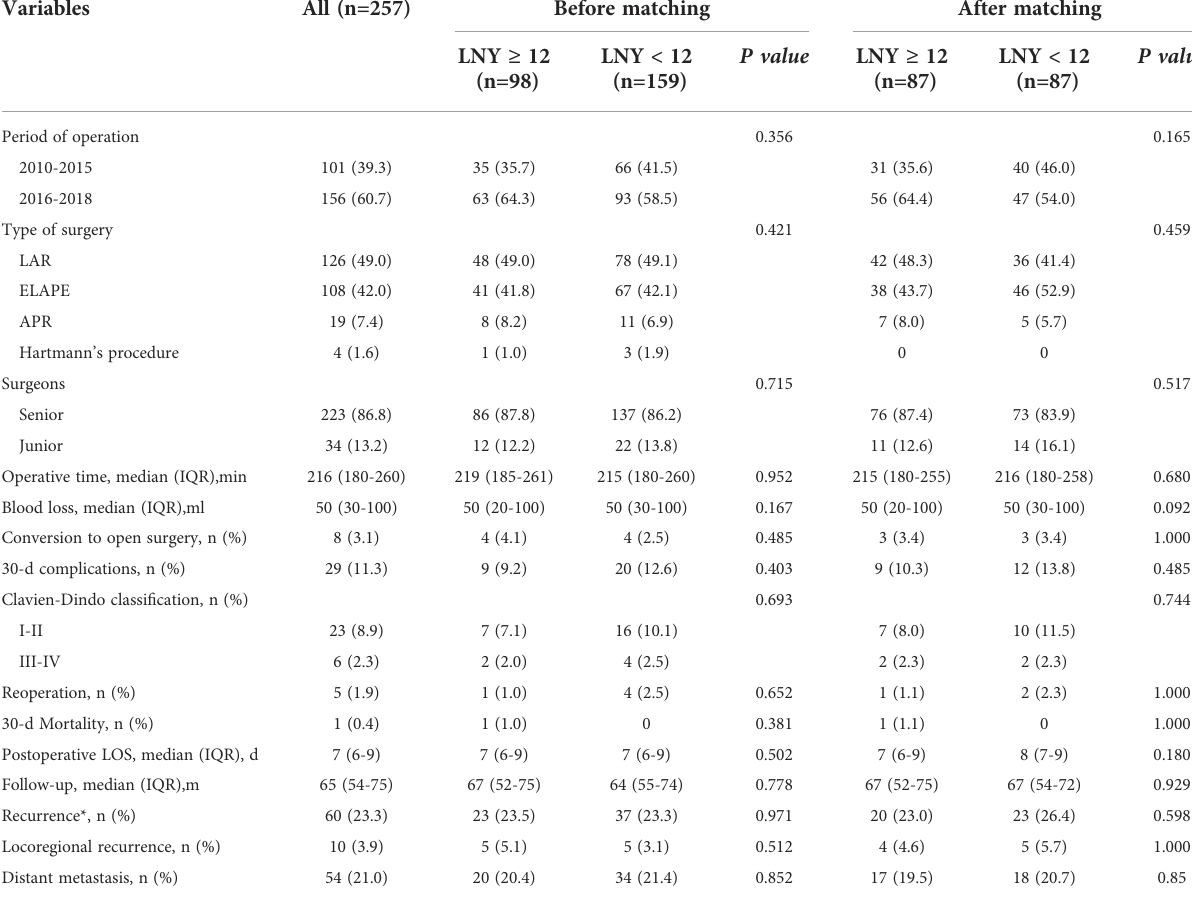
TABLE 3 Comparison of surgical outcomes between LNY ≥ 12 group and < 12